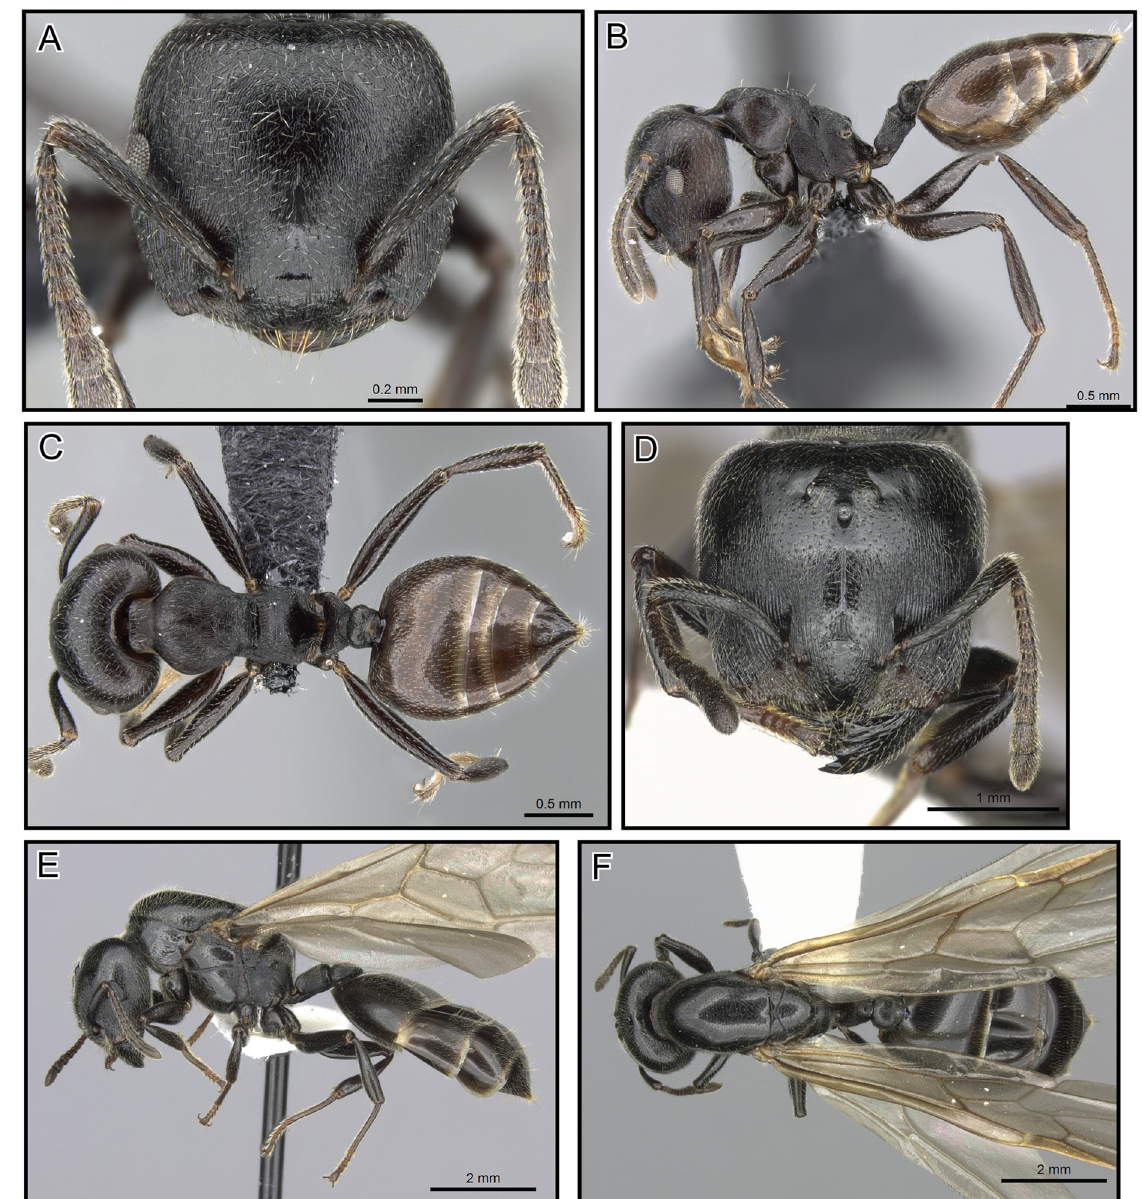
Fig. 13. Crematogaster mafybe sp. nov., worker and queen. A-C. Worker (CASENT0317762). A. Full- face. B. Profile. C. Dorsal. D-F. Queen (CASENT0193464). D. Full-face. E. Profile F.